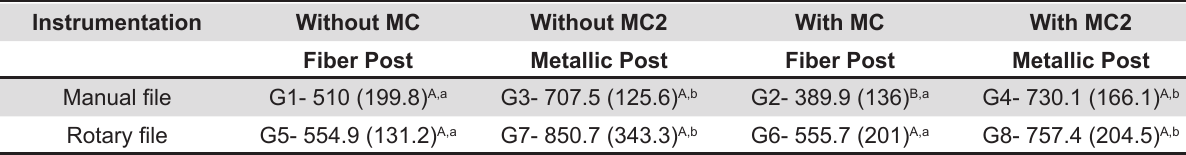
Table 1- Means (and standard deviation) of the results of the fracture resistance (N) for different groups